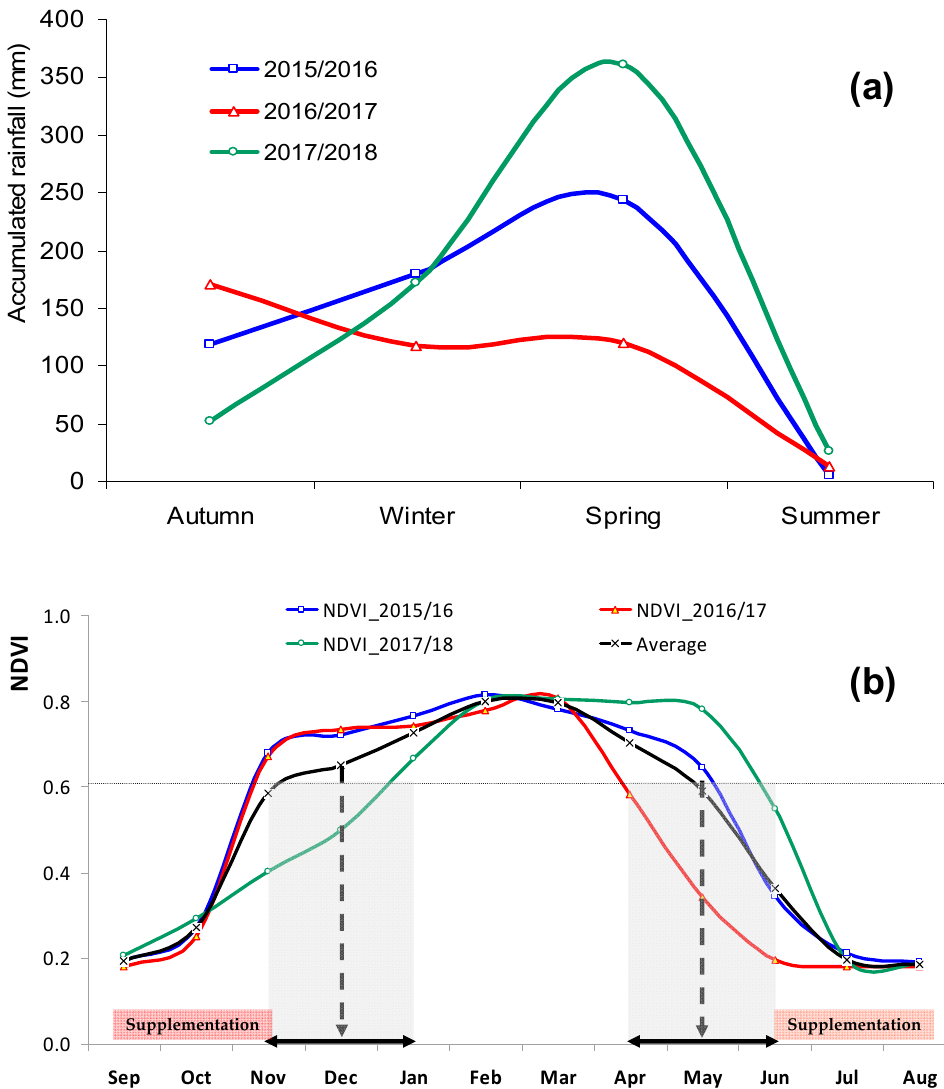
Figure 1. Season accumulated rainfall in the meteorological station of Mitra (Évora, Portugal) ( a ) and evolution of the normalized difference vegetation index (NDVI) at the experimental field ( b ) between September and August over three years: 2015/16, 2016/17, and 2017/18.